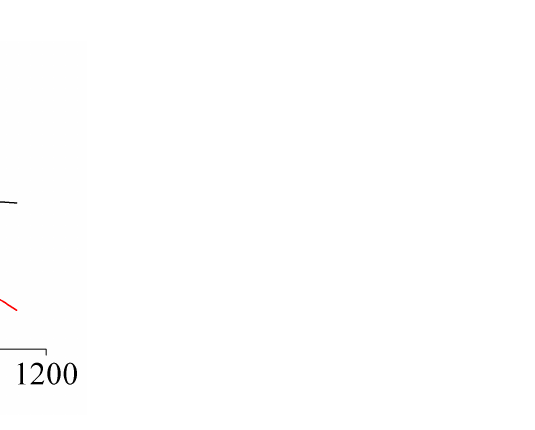
Figure 9. Temperature dependence of D and G peak height ratio H D / H G for nickel-containing and control samples.